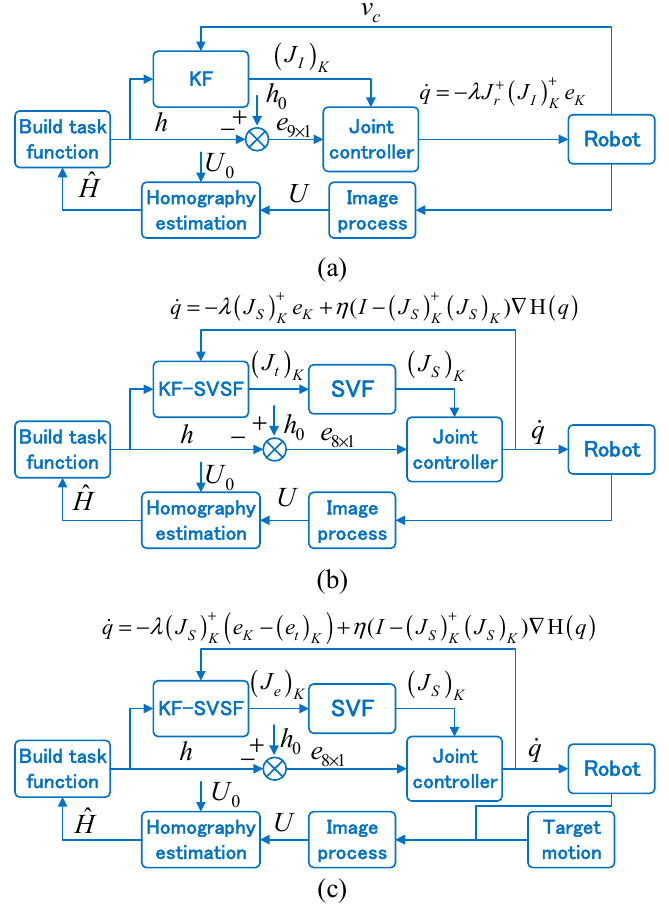
Figure 2. Visual servo system: ( a ) Original PHUVS block diagram. ( b ) Improved PHUVS block diagram for static positioning tasks. ( c ) Improved PHUVS block diagram for dynamic tracking tasks.